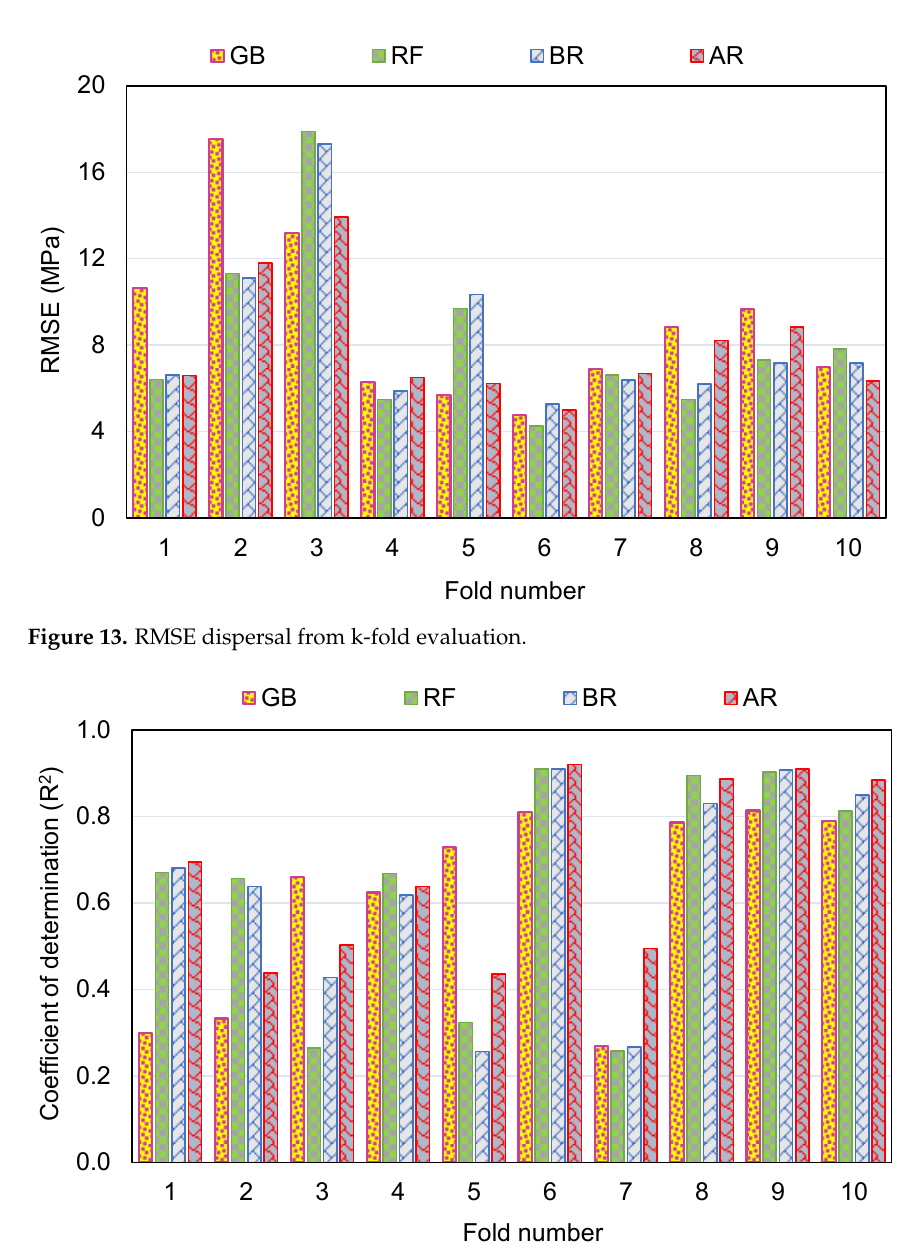
Figure 14. R 2 dispersal from k-fold evaluation. Table 3. MAE, RMSE, and R 2 results from the k-fold assessment.